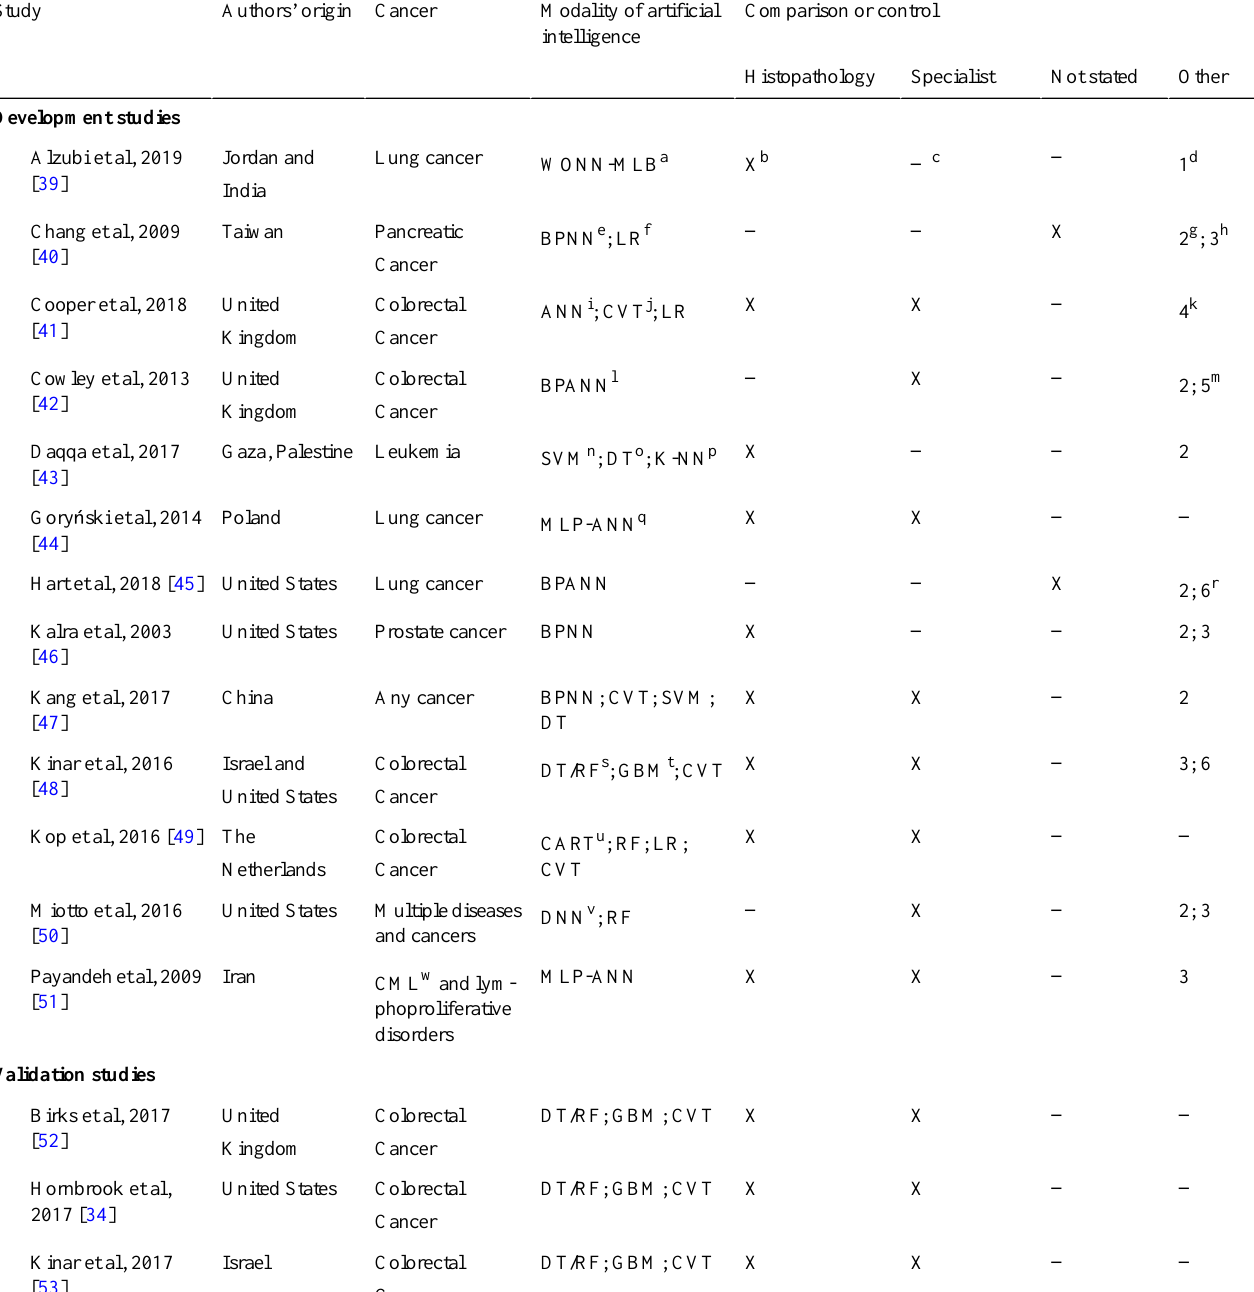
Table 1. Study details including modality of artificial intelligence and adopted comparison or control.